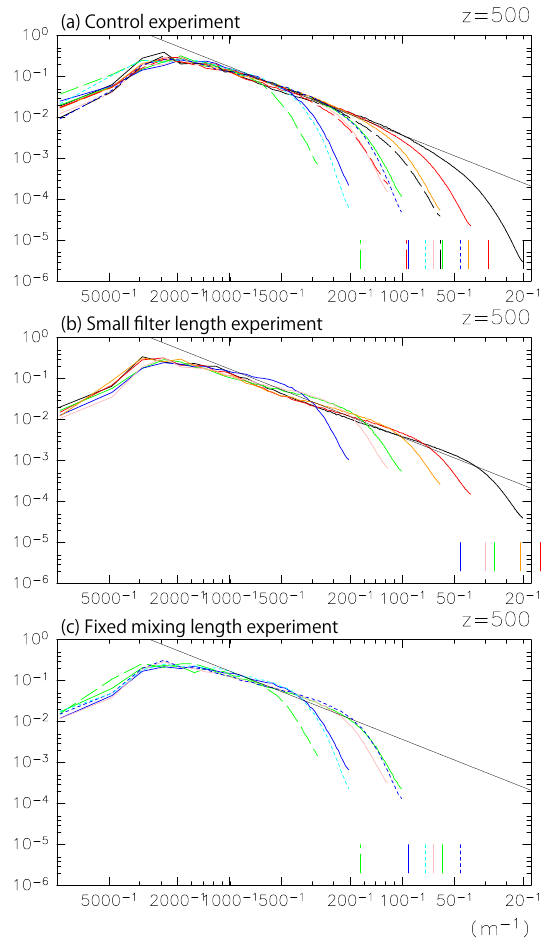
Figure 1. Energy spectrum three-dimensional velocity at height of 500m averaged over t = 3 . 5 to 4h in (a) control experiment, (b) small filter length experiment, and (c) fixed mixing length ex- periment. Colors indicate grid aspect ratio: 1 (black), 2 (red), 3 (orange), 5 (green), 6 (pink), 10 (blue), and 20 (cyan). Line types indicate vertical resolution: 10m (solid line), 30m (dashed line), and 5m (dotted line). Linear slope representing the slope of − 5 / 3 power fit to the spectrum of the 10mAR1 run between 1 / 1000 and 1 / 100m − 1 is superimposed. Only spectra for (cid:49)z = 10m runs in the small filter length experiment and for large aspect ratio runs ( a ≥ 5) in the fixed mixing length experiment are